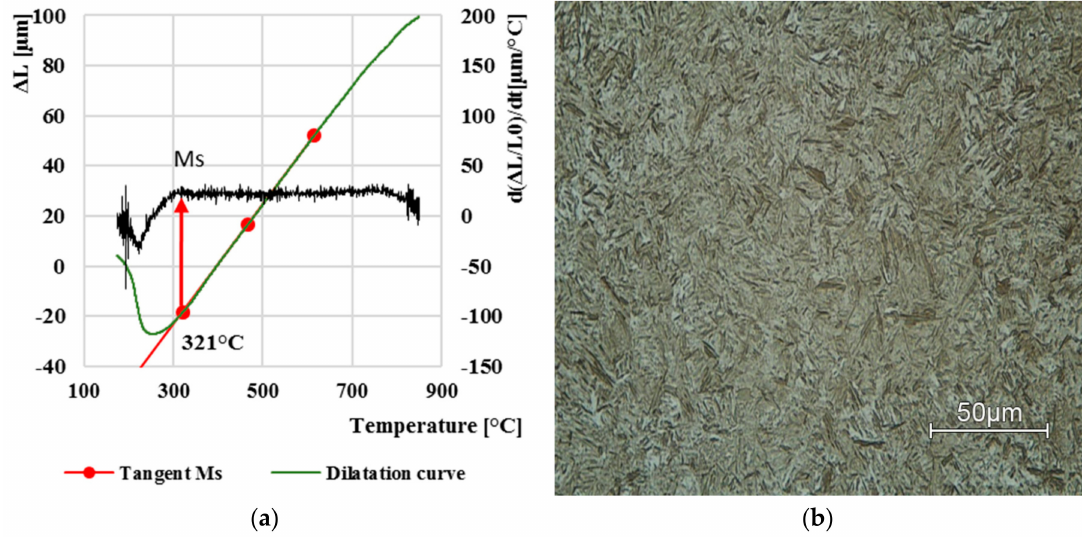
Figure 5. Dilatation curve ( a ); the final microstructure LOM ( b ) after cooling at 100 ◦ C · s − 1